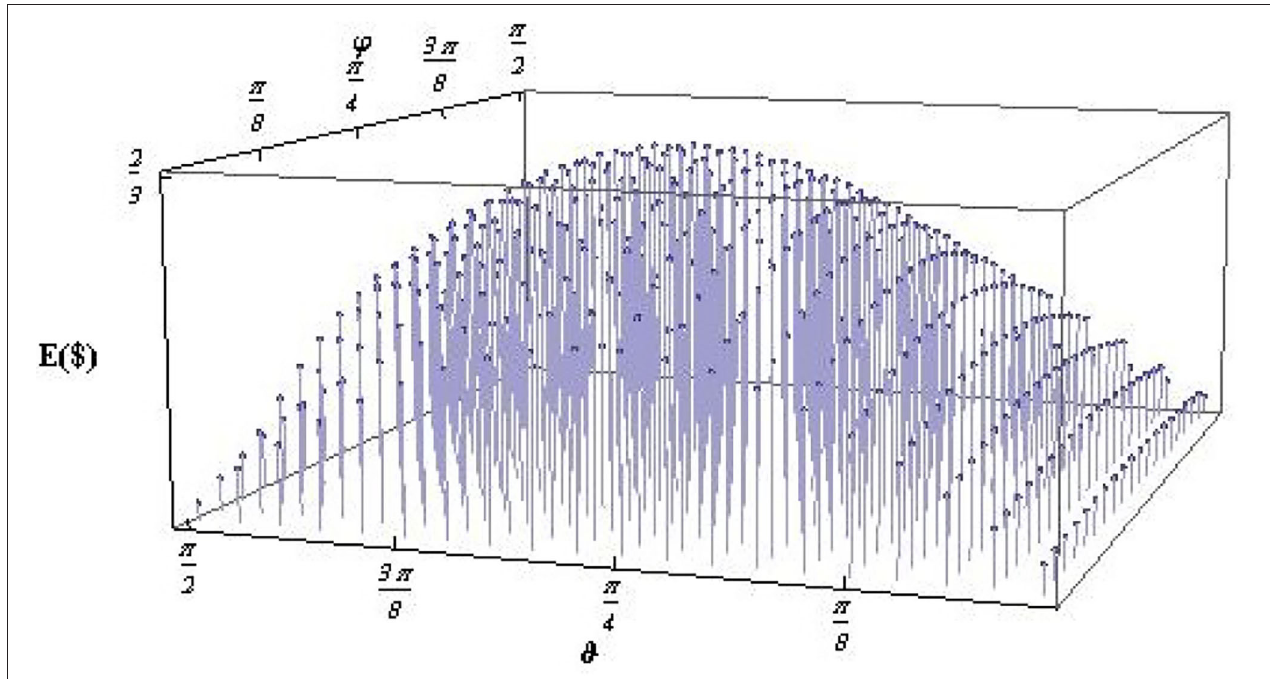
FIGURE 3 | Expected payoff E ( $ ( U opt , ϑ , ϕ )) as a function of ϑ and ϕ , for a quantum KPR game with three players and three choices with the optimal strategy operator U opt . Each pair of ϑ and ϕ indicates a different initial state according to Equation (25). The peak in E ( $ ) occurs for a maximally entangled initial state, i.e., for ϑ π/ 4 (taken from Sharif and Heydari, cos − 1 (1 / √ 3) and ϕ = =